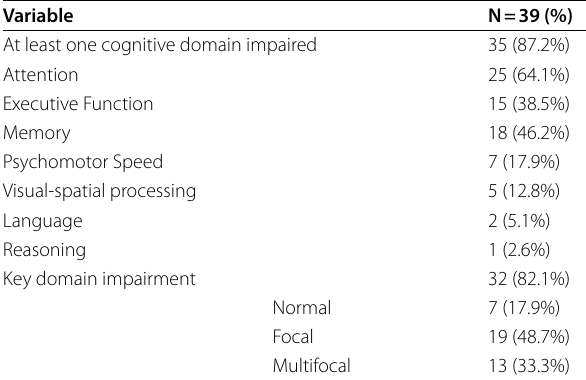
Table 2 Frequency of cognitive impairment in each domain